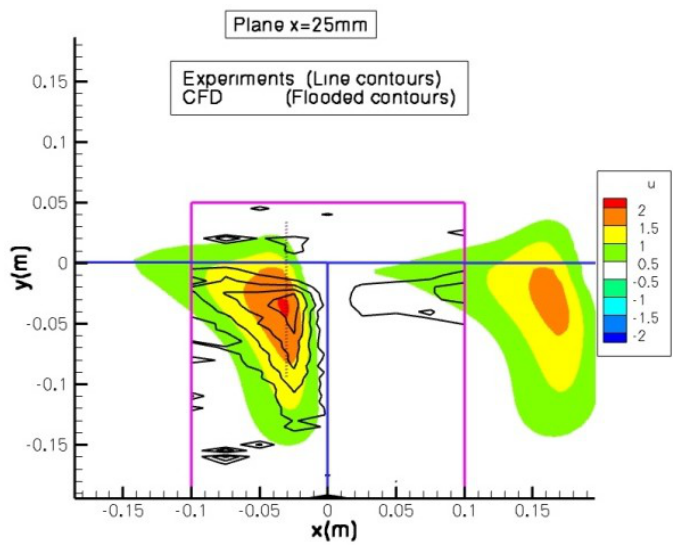
Figure A1. Radial velocity contours comparison between CFD and experiments for single phase velocity